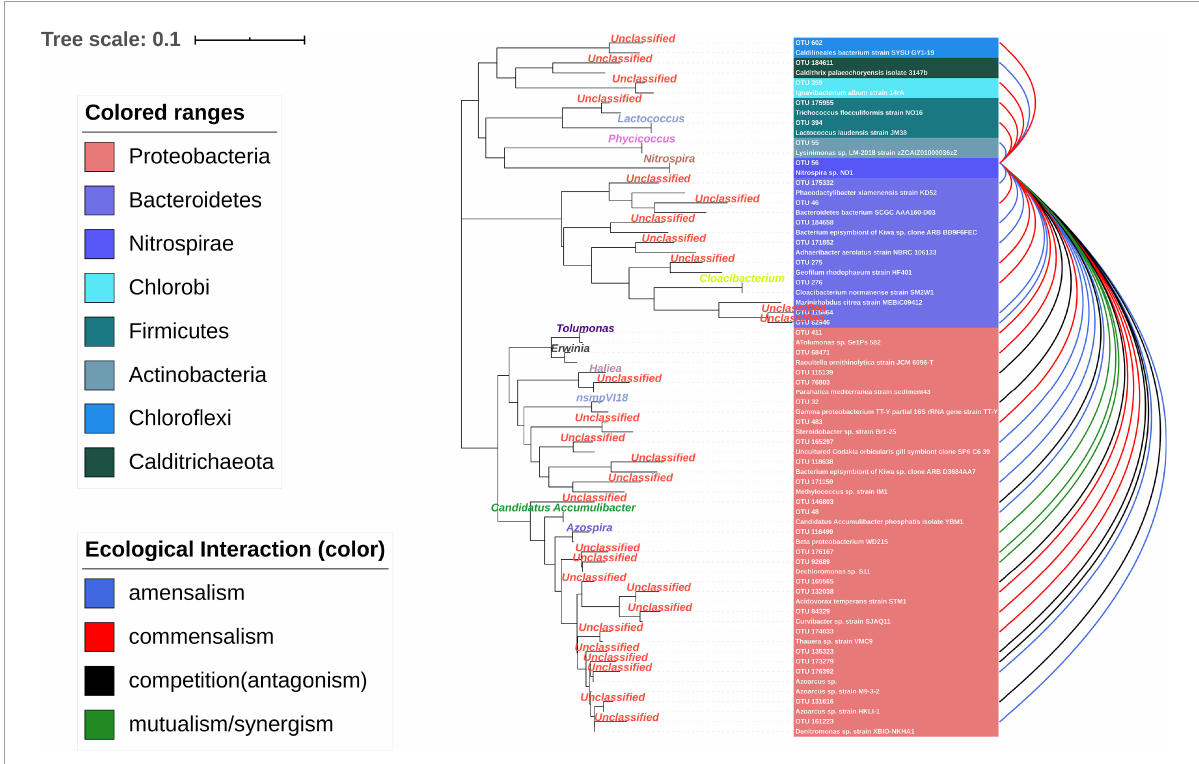
FIGURE5 Ecological interaction of OTU56 with others at the OTU level. The color represents the type of interaction. The phylogenetic tree shows the closest species according to the results of the NCBI